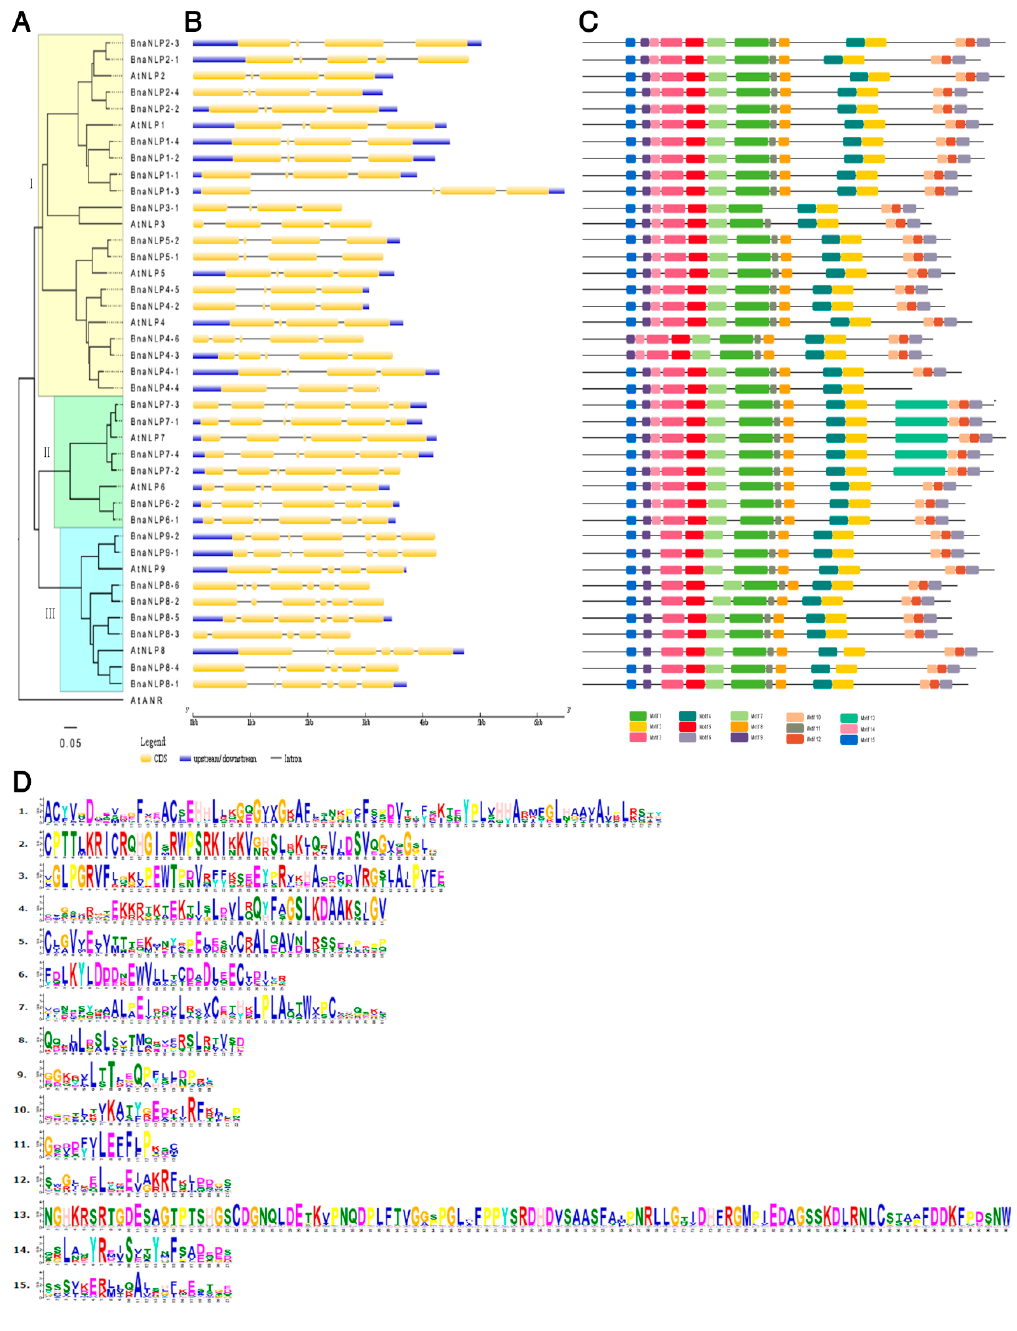
Figure 1. Phylogenetic relationships, gene structures, and conserved motifs of NLP proteins in A. thaliana and B. napus . The amino acid sequences of AtNLPs and BnaNLPs were aligned using ClustalW2. ( A ) The phylogenetic tree was constructed using MEGA 7.0 with the neighbor-joining method (1000 bootstrap replicates) and displayed using FigTree v1.4.0. The 40 NLP proteins in A. thaliana and B. rapa are clustered into three distinct groups. The scale bar represents 0.05 kb. At: A. thaliana ; Bna: B. napus ; ( B ) gene structures generated using the Gene Structure Display Server. Exons (CDS) and introns are shown with yellow wedges and black lines, respectively. Numbers 0, 1, and 2 represent introns in phases 0, 1, and 2, respectively; ( C ) conserved motifs of BnaNLP proteins identified by MEME. The motifs are indicated by colored boxes and their numbers are shown in the scale below the diagram; ( D ) sequences of the 15 conserved motifs in BnaNLPs identified in this study.